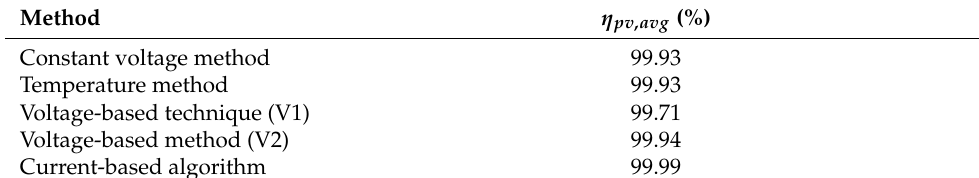
Table 4. Average efficiencies of the model-based MPPT techniques at ramp variations of radiation.